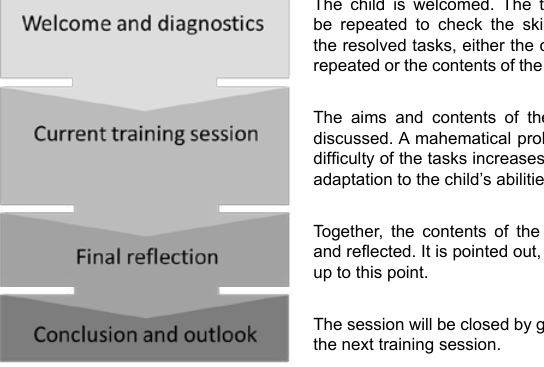
Figure 3: Structure of a training unit in the support programme MARKO-T.